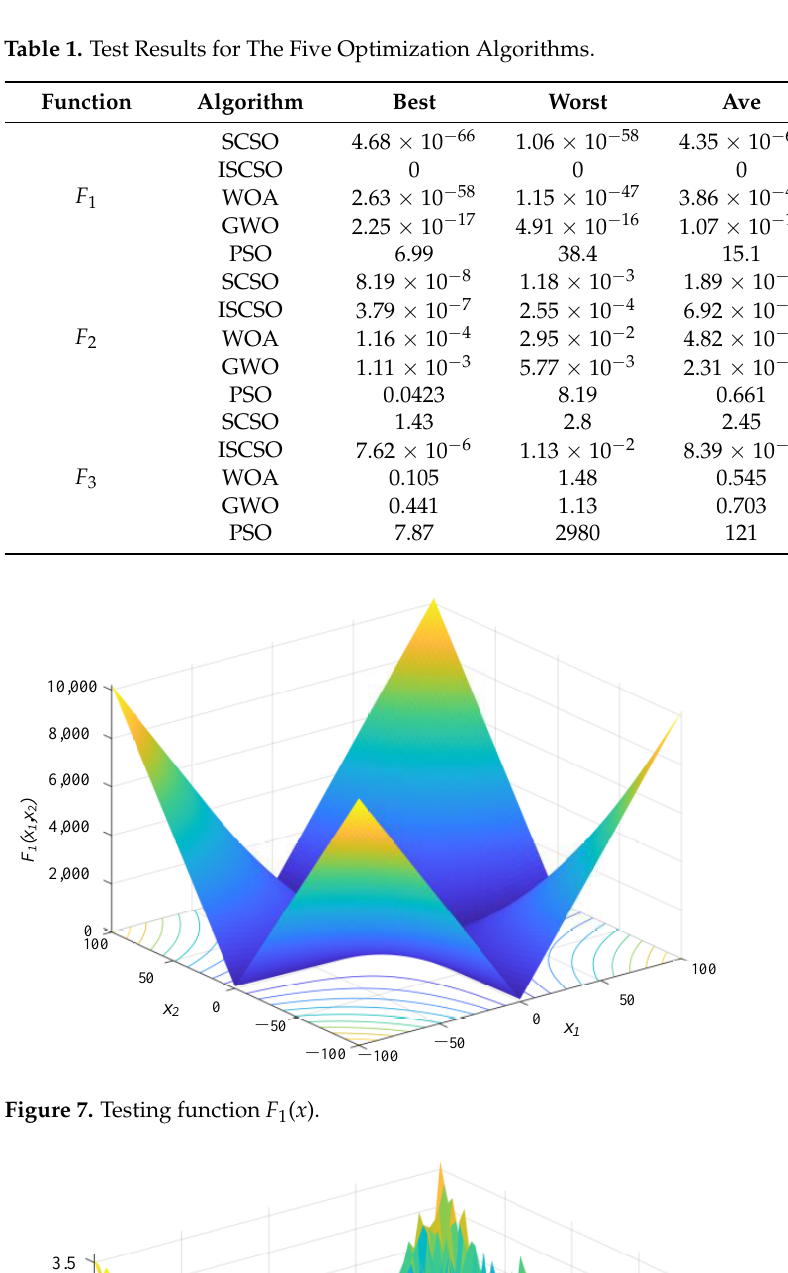
Figure 9. Testing function F 3 ( x ).